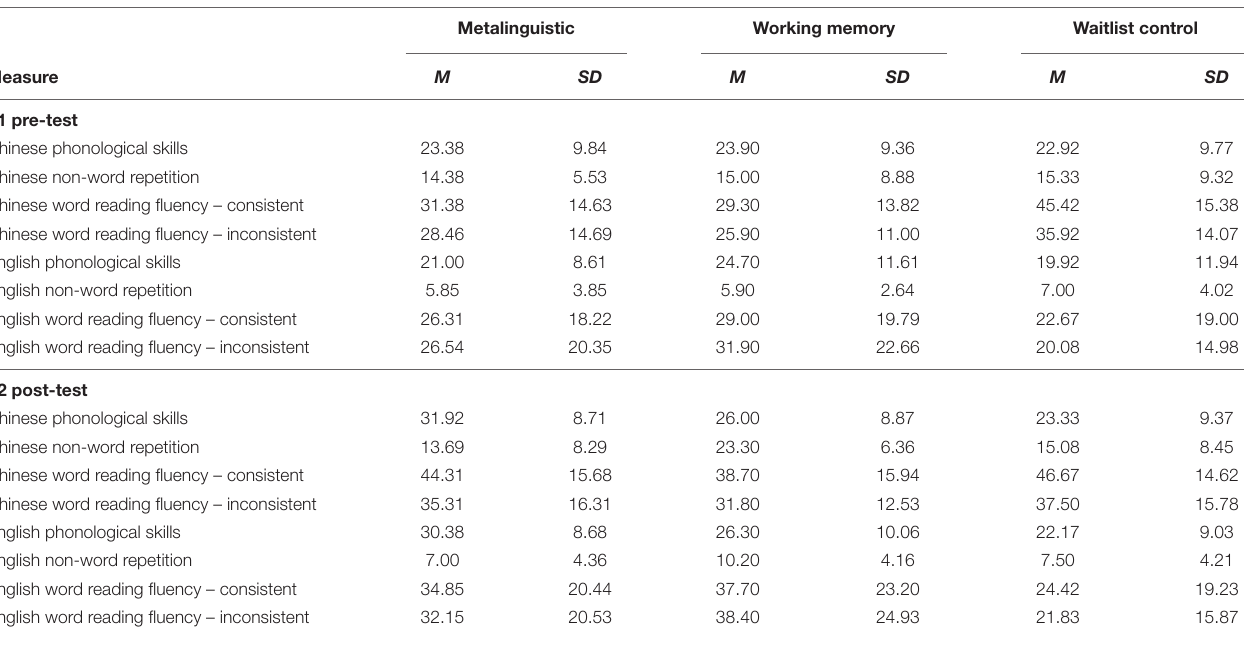
TABLE 2 | Pre-test and post-test mean performances on all measures for training and control